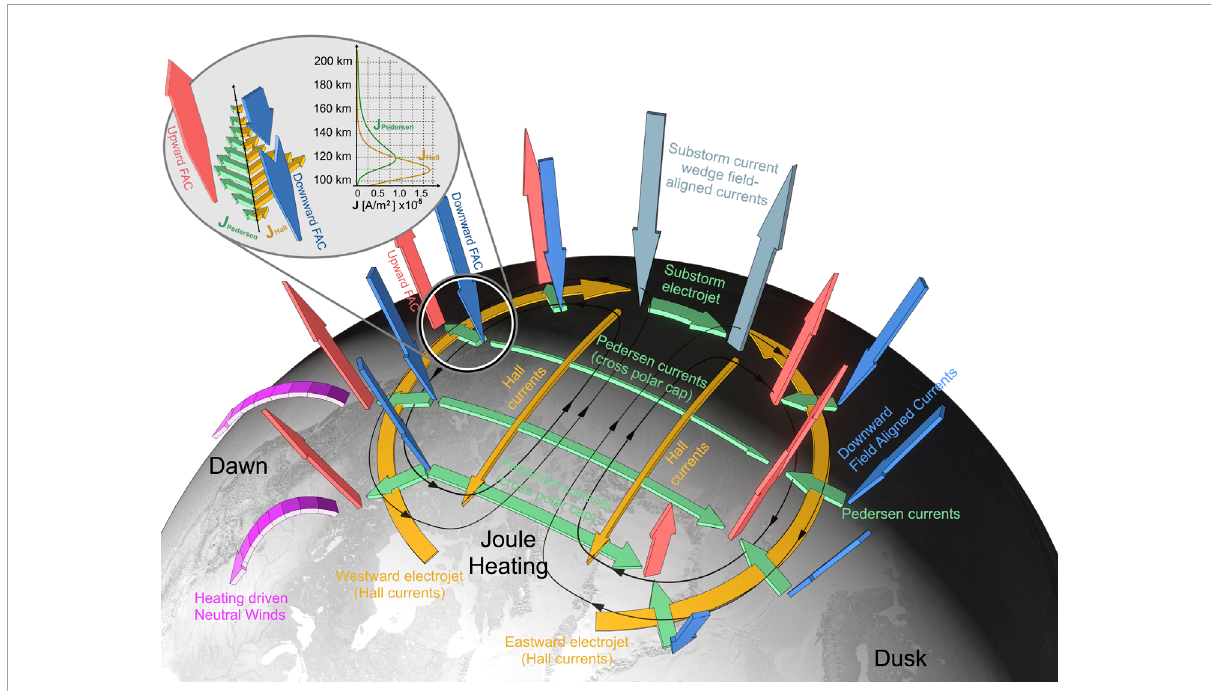
FIGURE 1 The closure of field aligned currents at high latitudes via perpendicular currents within the altitudes where plasna-neutral interactions maximize leads to Joule heating that subsequently modifies the neutral wind and density patterns at lower latitudes. The vertical structure of Hall and Pedersen perpendicular currents are drawn in the upper left inset of this figure based on Global Circulation Model results. Adapted from ESA Daedalus RfA